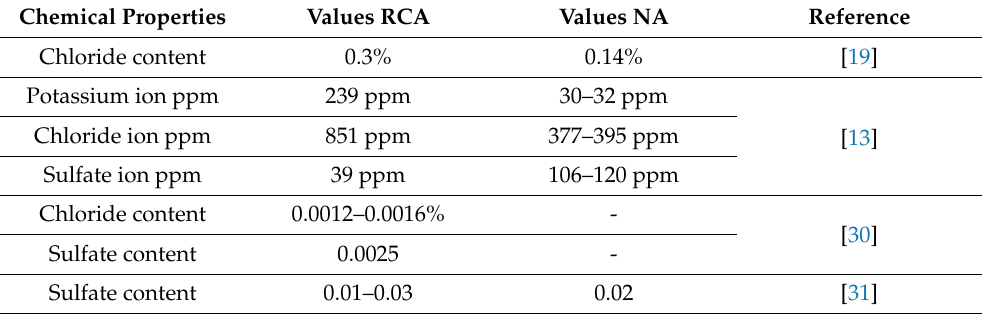
Table 3. Comparison of chemical properties between RCA and